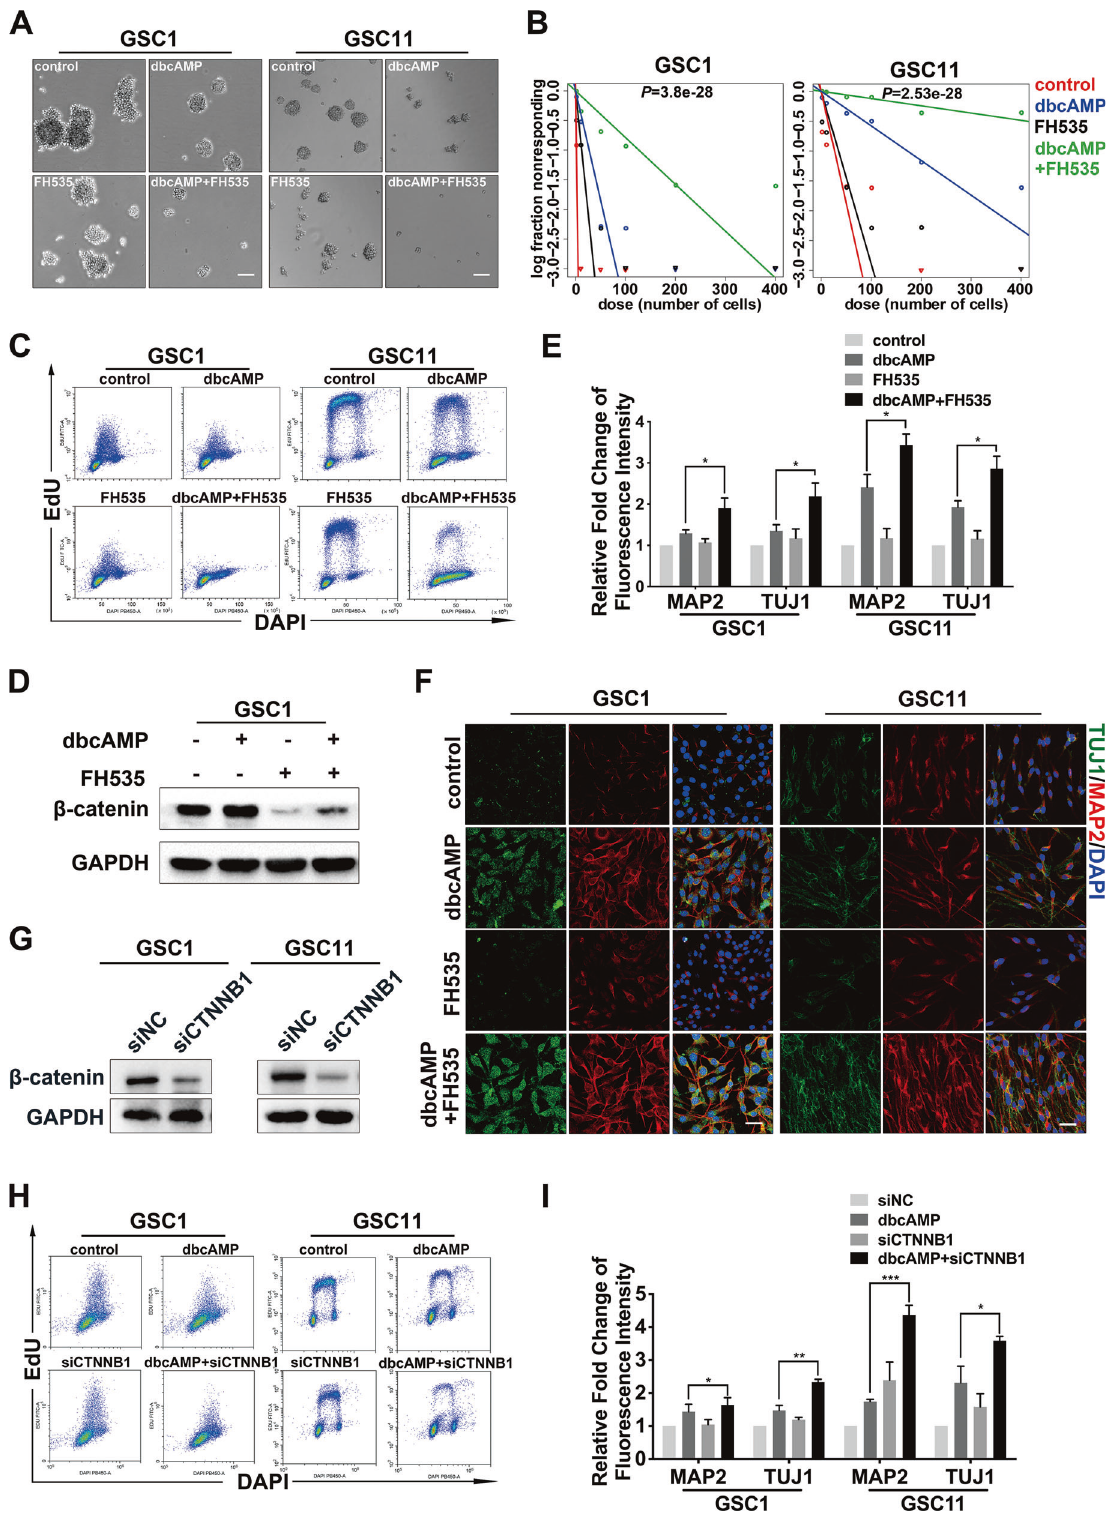
Fig. 4 Suppression of β -catenin promotes cAMP-induced differentiation in GSCs. A Phase-contrast image of neurospheres formed by GSC1 and GSC11 cells after various treatments for 72 h (scale bar, 100 μ m). B Limiting dilution assays of GSC1 and GSC11cells treated with dbcAMP, FH535, and the combination of dbcAMP and FH535. C Proliferation was evaluated by EdU incorporation analysis in GSCs treated with dbcAMP, FH535, and the combination of the two agents. D Western blot of β -catenin in GSC1 treated with dbcAMP and FH535. E Quanti fi cation by fl ow cytometry of MAP2 and TUJ1 in GSCs incubated with dbcAMP and FH535. F Immuno fl uorescence staining of MAP2 (red) and TUJ1 (green) in GSCs with different treatments (scale bar, 50 μ m). G Western blot of β -catenin in GSCs treated with siRNA speci fi c for β -catenin (siCTNNB1). H Proliferation evaluated by EdU incorporation analysis of GSCs with β -catenin knock-down. I Quanti fi cation of MAP2 and TUJ1 in GSCs with β -catenin knock-down by using fl ow cytometry. (Data are shown as the mean ± SD. N.S., not signi fi cant; *, p < 0.05; **, p < 0.01; ***, p < 0.001). Cell Death and Disease (2022)